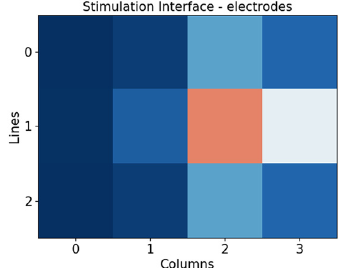
Figure 14: The touch can be detected in multiple points at the same time.